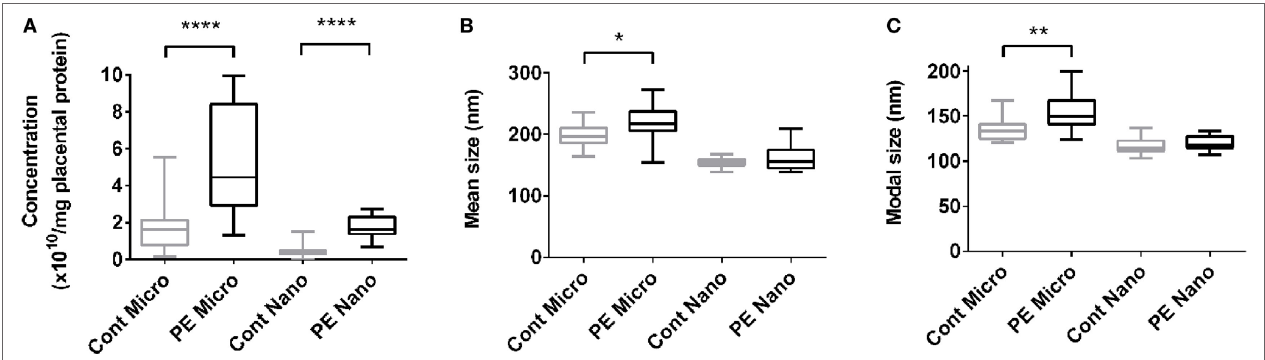
FigUre 1 | Production of micro- and nano-vesicles by PE placentae. Box and whisker graph demonstrating the amount of micro- and nano-vesicles extruded from normotensive (cont, n = 10) or preeclamptic (PE, n = 8) placental explants, normalized to the protein content of the originating placental explant (a) , and their mean (B) and modal (c) size. As data was not normally distributed, data is plotted as the median, interquartile range and range; and a Mann–Whitney test was performed to examine statistical differences between control and PE groups (* p < 0.05, ** p < 0.01, **** p <